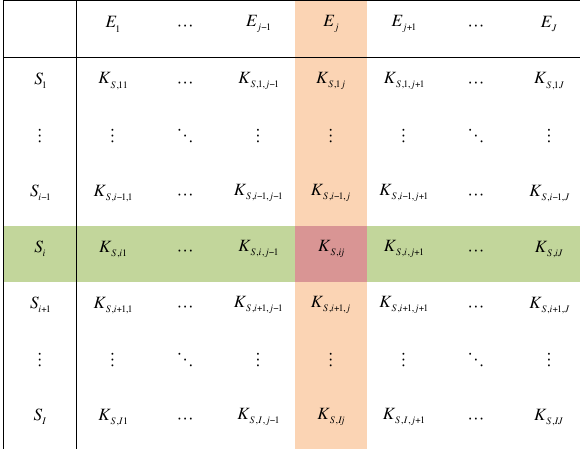
Fig. 1. A matrix-based representation of the parameter configura- tion for the ECA substrate kinetics (Eq.